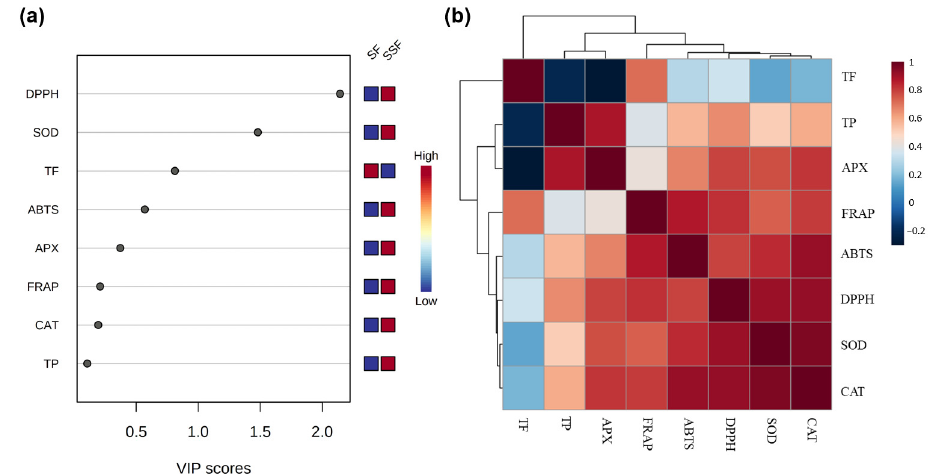
Figure 4. VIP scores of PLS-DA analysis ( a ) and correlation matrix ( b ) between total polyphenol, flavonoid, content, and antioxidant activities according to the different solvent extracts of Sargassum fusiforme . The intensity of red and blue colors represents positive and negative correlations. TP: Total polyphenol content, TF: Total flavonoid content.